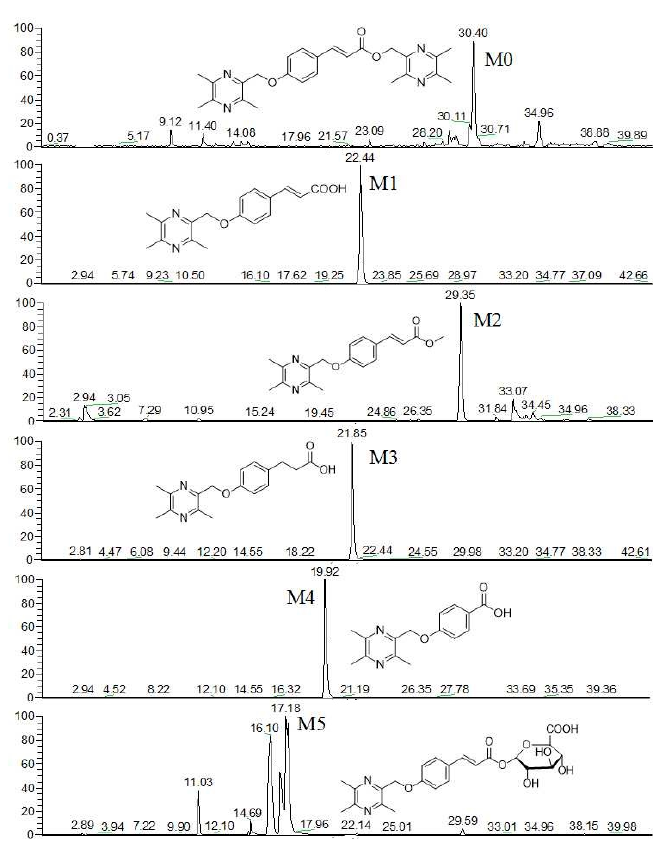
Figure 3. The ion flux and structure prediction of metabolites.